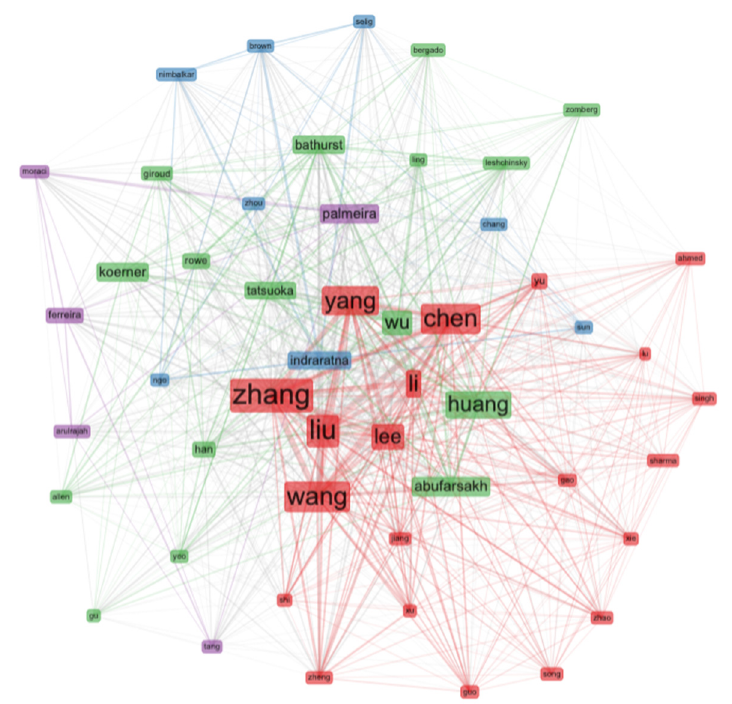
Figure 12. Authors’ co-citation network.